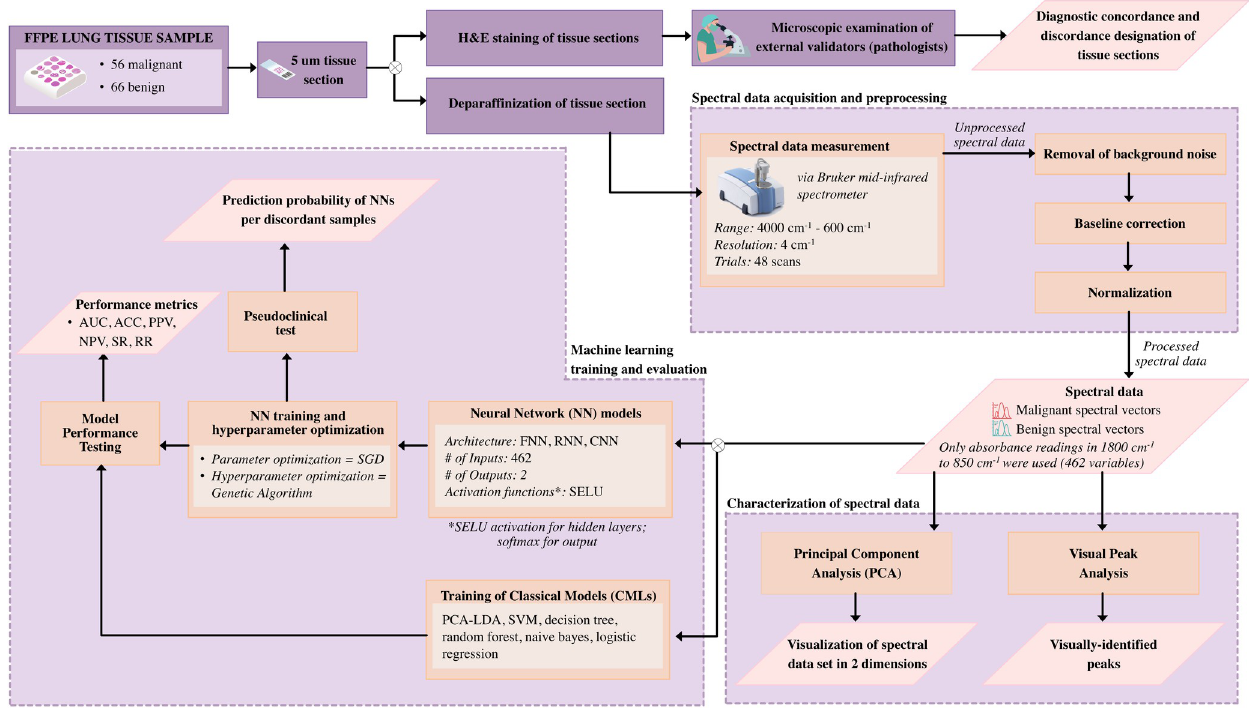
Fig 1. Experimental design process flowchart. The figure shows the experimental design of the study from acquisition of spectral data to machine learning training and evaluation.